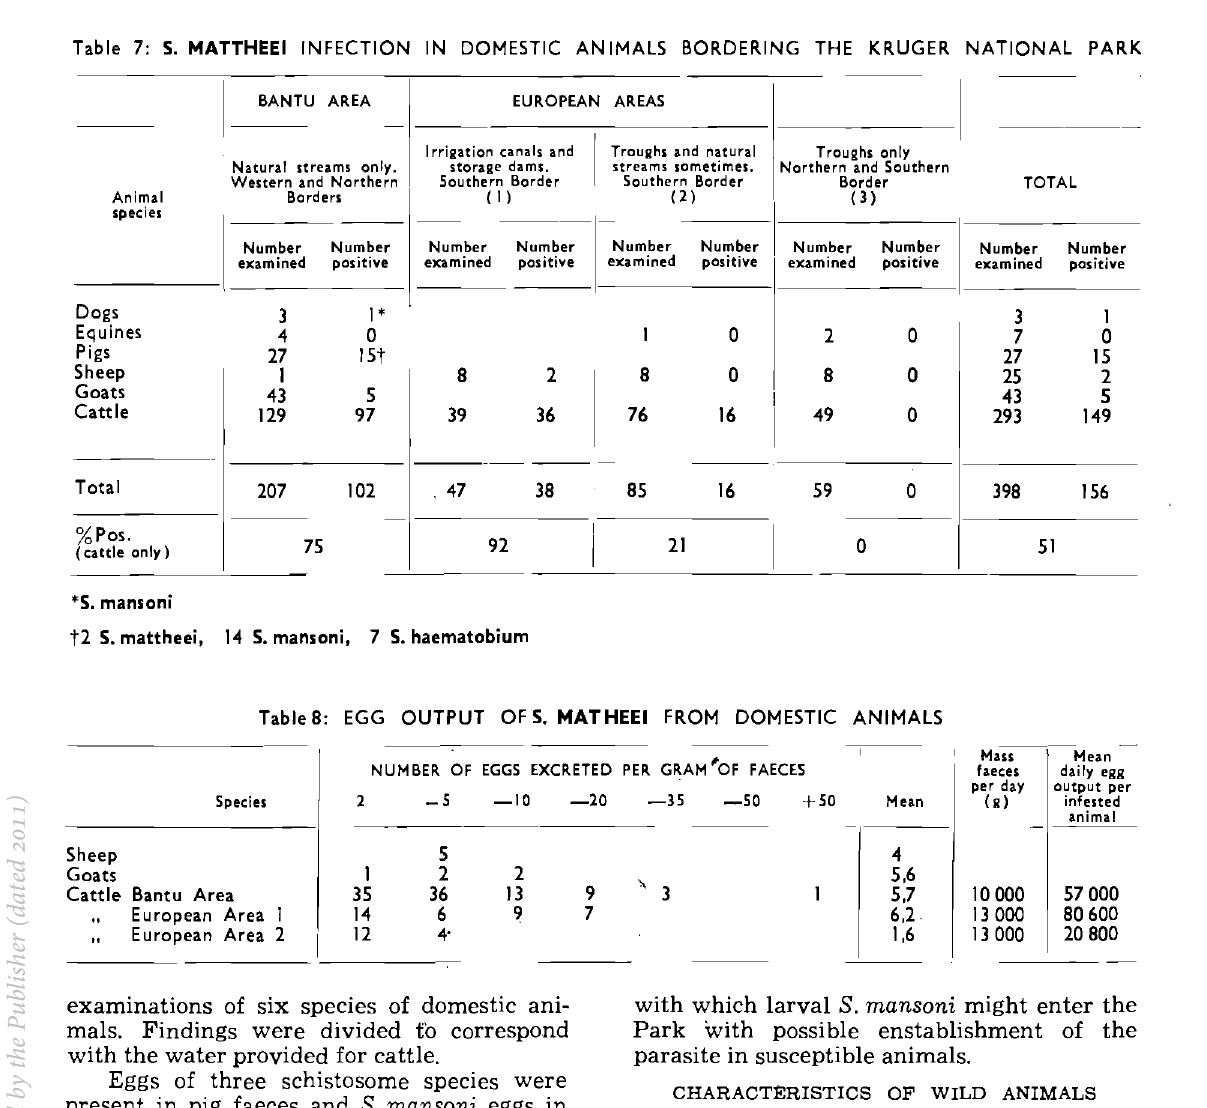
Table 7: 5. MATTHEEI INFECTION IN DOMESTIC ANIMALS BORDERING THE KRUGER NATIONAL PARK BANTU AREA EUROPEAN AREAS I I rrigation canals and Troulhs and natural Troughs only I Natural streams only.